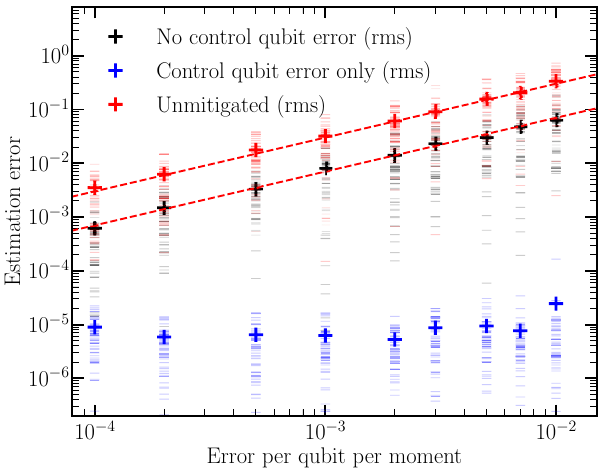
FIG. 9. Mitigation of the same four-qubit VHA circuit as in Fig. 4 of the main text, but with either depolarizing noise on only the system register (black) or on only the control qubit (blue). This is compared with the error in estimation using partial state tomography instead of VPE (red). For each dataset, the rms error (crosses) is plotted over 50 different estimations for each error rate (with randomly chosen ansatz parameters), and individual data points are plotted as dashes behind. For reference, dashed lines showing linear (red) dependence on the gate error rate are